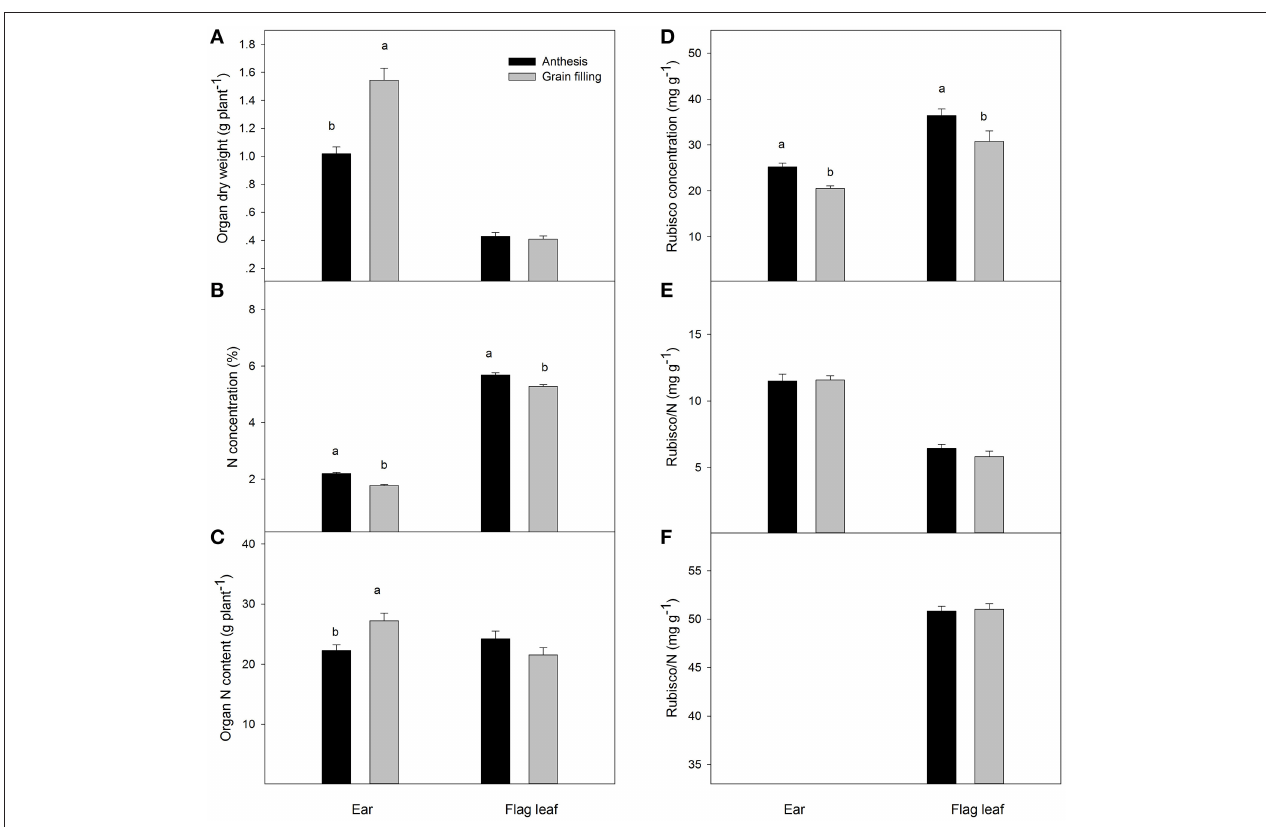
FIGURE 1 | Organ dry weight (A) , N concentration (B) , whole organ N content (C) , Rubisco concentration (D) , Rubisco per N (E) and Chl. readings (SPAD 520 value) (F) of whole ears and flag leaves during anthesis and 2 weeks after anthesis. Mean values with different superscripted letters are significantly different according to the Tukey’s honestly significant difference test ( P <